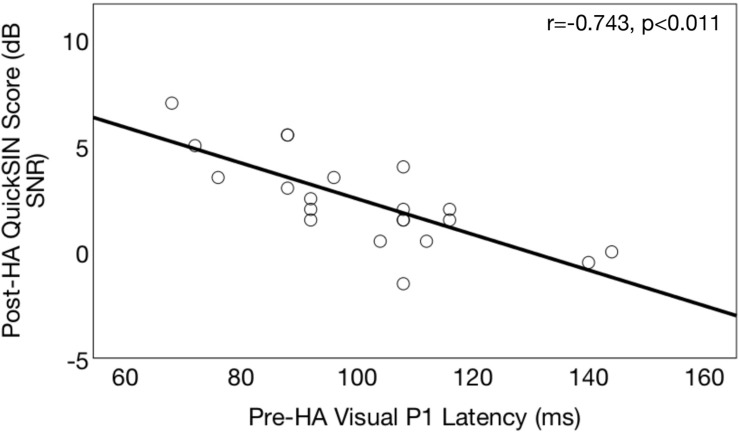
Association between pre-treatment cortical visual evoked potential latencies and post-treatment auditory speech perception in noise outcomes in age-related hearing loss. Correlations between pre-treatment neurophysiological outcomes and post-treatment speech perception outcomes are shown for a group of adults with hearing loss (n = 21) who received treatment with hearing aids. Pre-treatment right temporal P1 CVEP peak latency (in milliseconds) is displayed on the horizontal axis and performance 6 months post-treatment binaural aided auditory speech perception in noise performance (QuickSINTM score) is depicted on the vertical axis. QuickSINTM scores are plotted in terms of the dB signal-to-noise ratio loss (dB SNR), representing the dB SNR required for the participant to score 50% of words in a sentence correct relative to normal hearing listeners. A higher score indicates poorer auditory speech perception in noise performance. Earlier pre-treatment P1 CVEP latencies (an index of visual cross-modal re-organization) are predictive of poorer post-treatment auditory outcomes.